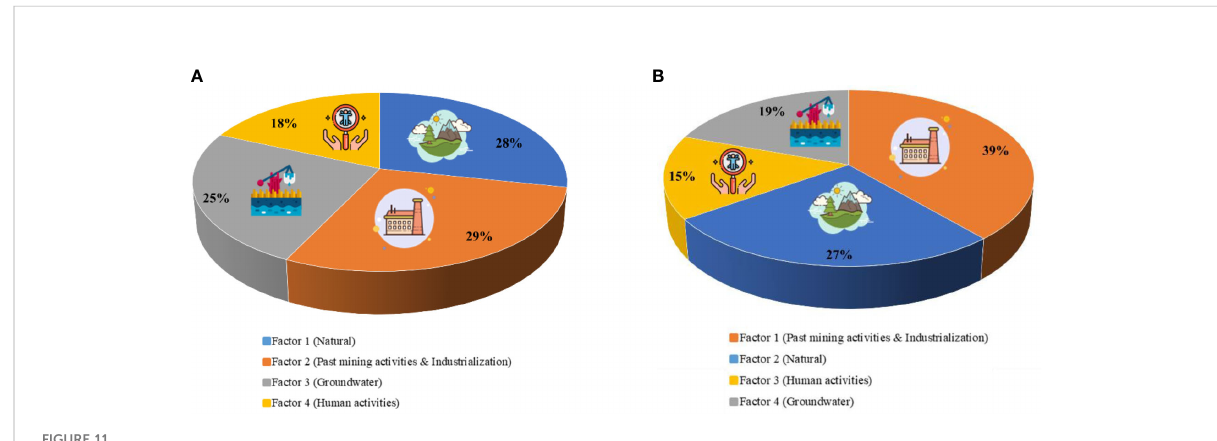
FIGURE 11 Source factorization of (A) recreational soil and (B) agricultural